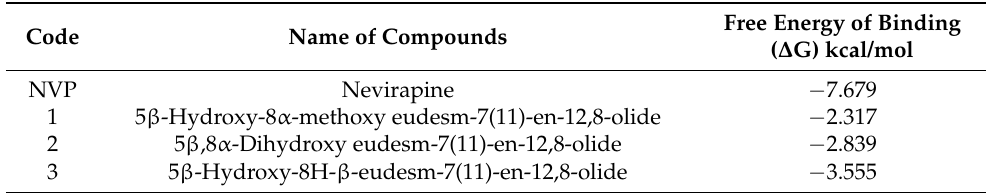
Table 3. Molecular docking analysis of against HIV-1 reverse transcriptase in complex with Nevirap- ine (PDB ID: 1JLB).